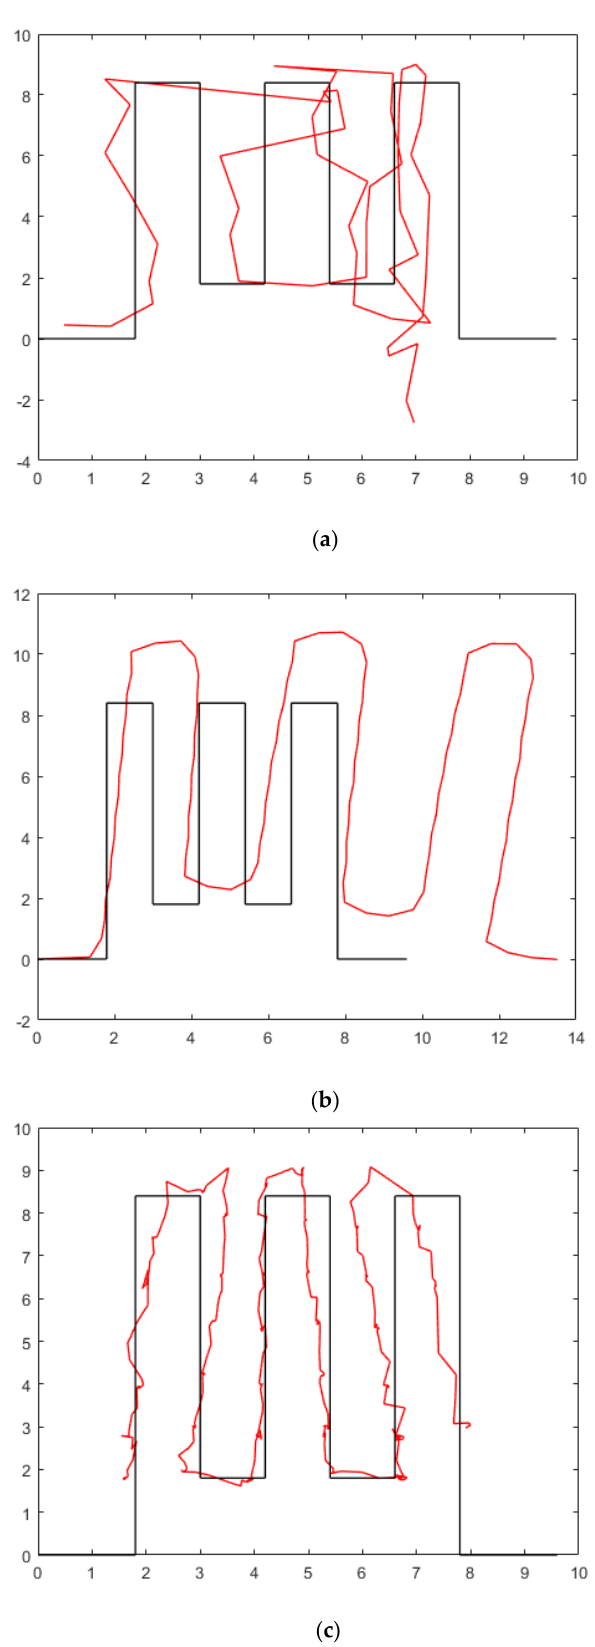
Figure 15. Test-points and camera deployment. ( a ) MM. ( b ) PDR. ( c ) Passive visual. Figure 16 and Table 4 show all the statistical results and the CDF of the positioning error. The red curve represents the passive visual localization results based on passive vision, the green curve represents the results based on MM, and the blue curve repre- sents the results based on PDR. The orange and light blue lines represent the 90% and 95% errors, respectively. The passive visual method performed better in indoor positioning than PDR and MM. The positioning errors of 90% and 95% of the passive visual method were smaller than those of PDR and MM. The RMS error of the positioning method is 0.643 m, 2.581 m, and 1.4351 m. The maximum error of the positioning method is 2.175 m, 4.364 m, and 3.919 m. It is shown that our methods can perform well in the hall envi- ronment. Furthermore, in contrast to the active vision positioning method, our approach does not require the user to take a photo, nor does it require a database of images for every place. Figure 16. CDF of various positioning methods.